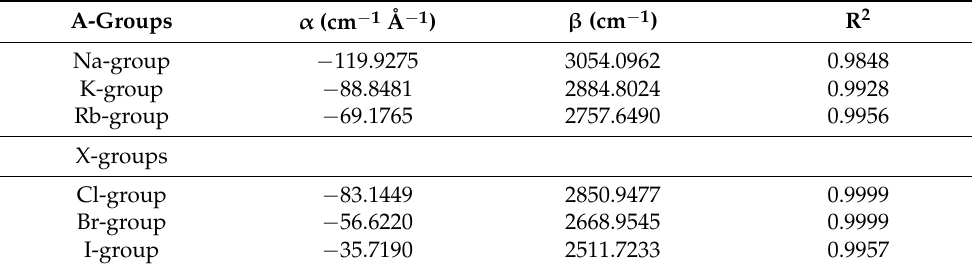
Table 4. Empirical constants ( α and β ) of the linear relationship ν 3 (i-BH 4 − ) = α .a 0 (AX) + β for common cation A- series and common anion